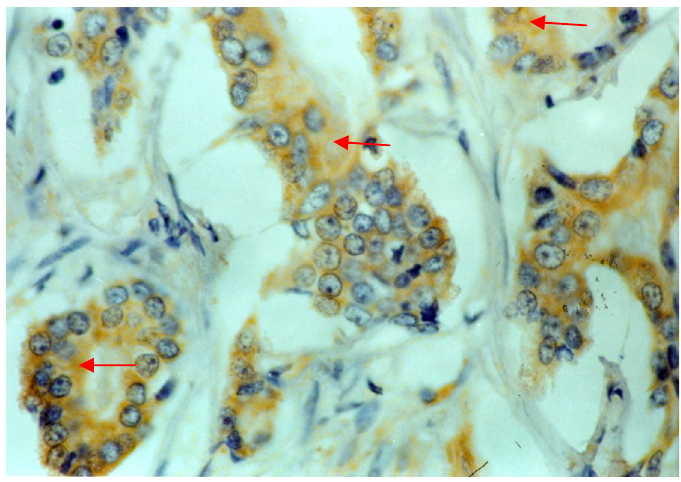
Figure 4. Photomicrograph showing nm23H1 expression in cells of prostate cancer tissue,